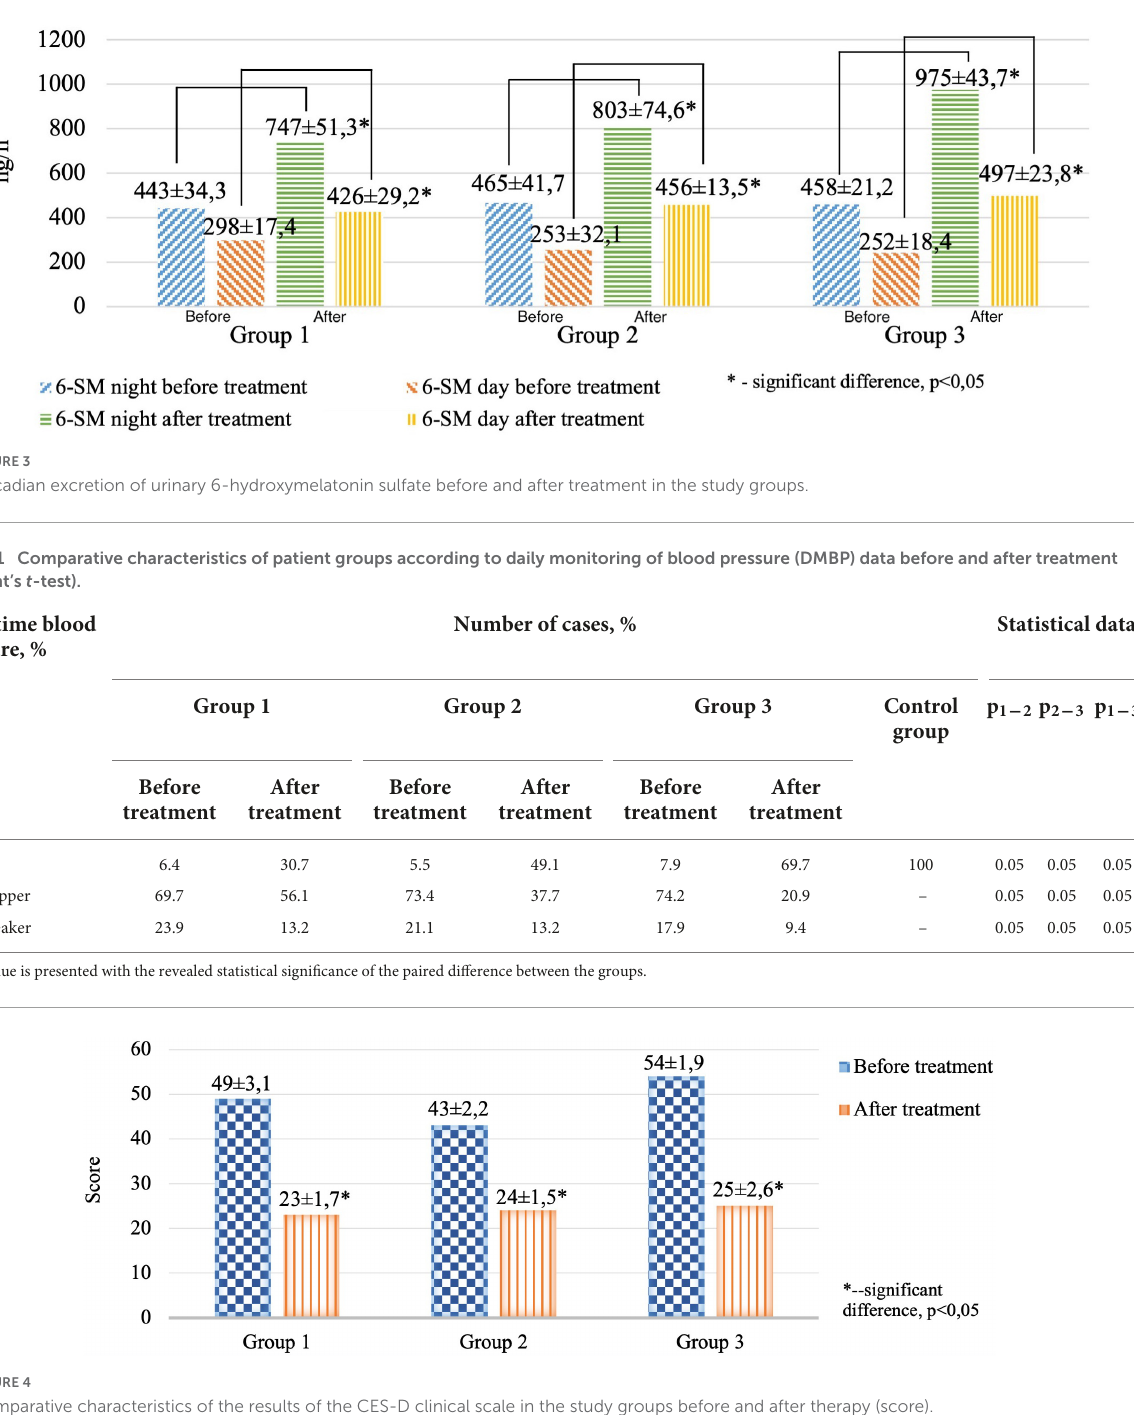
fibrillation due to occlusion and reopening of the anterior descending coronary artery (Tan et al.,